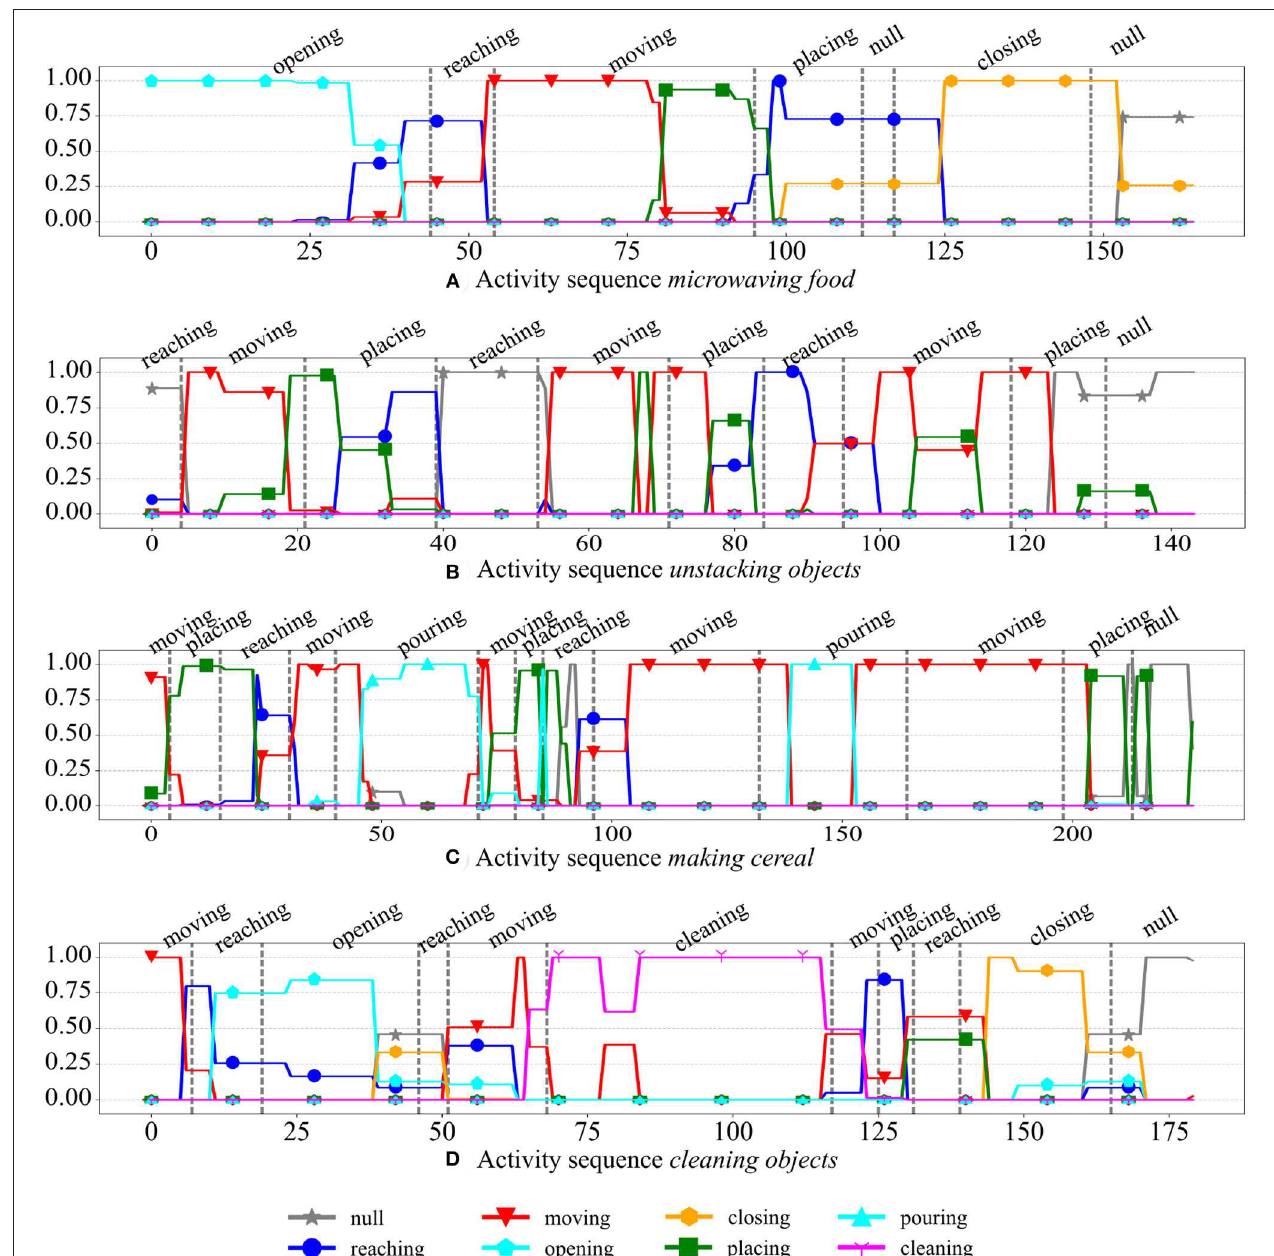
FIGURE 8 | Examples of output labels of the GWR a network (actions) for the test subject 1 of the CAD-120 dataset (Mici, 2018). The ground-truth temporal segmentation of the actions is illustrated with vertical gray dashed lines. The ground-truth action labels are reported on top of each